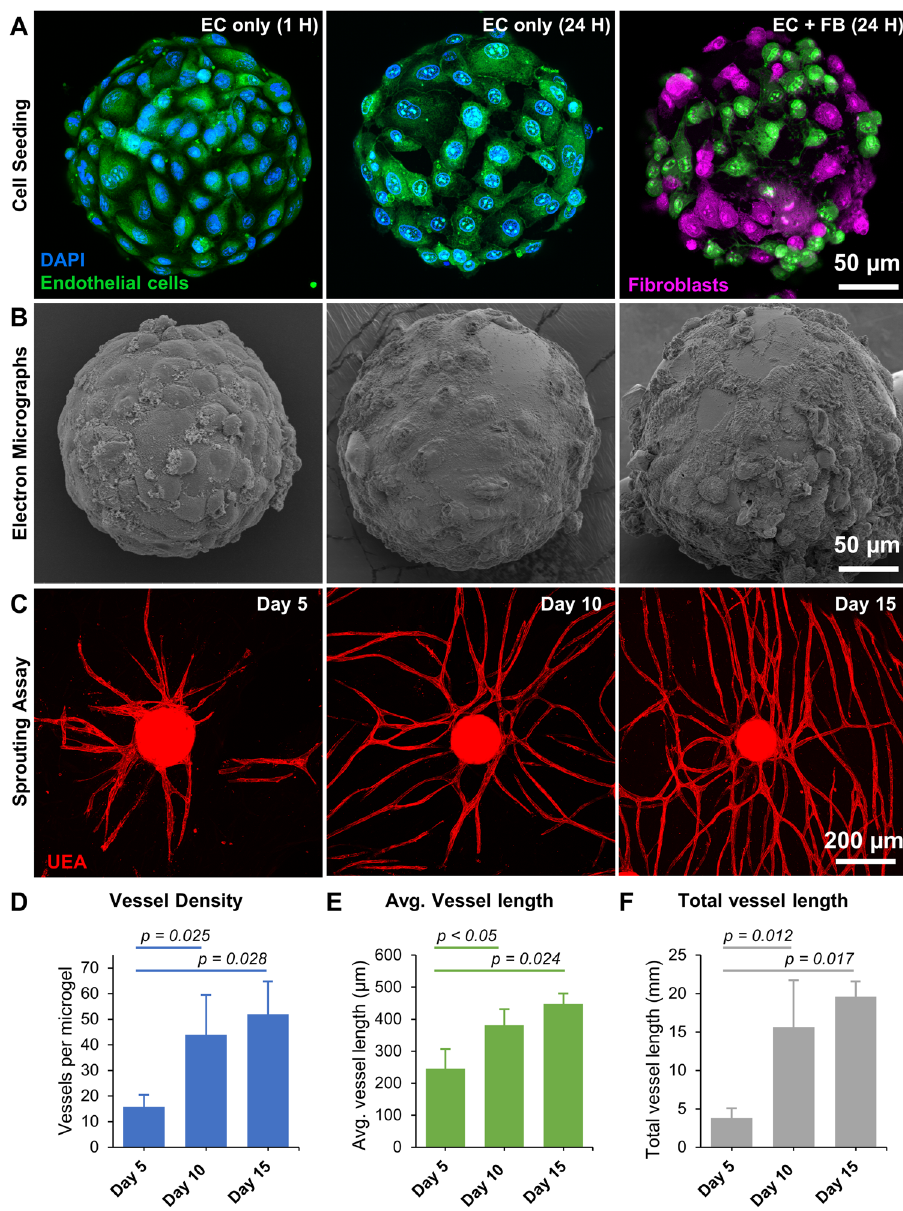
Figure 6. Gelatin microgels supported robust endothelial sprouting. ( A ) Confocal stacks of endothelial cells and fibroblasts seeded on gelatin microgels. The endothelial cells exhibit a typical ‘cobblestone’ monolayer pattern (left and center), which was changed when seeded with fibroblasts (right). ( B ) Corresponding scanning electron micrographs of microgels showing cell attachment to the microgel surface. ( C ) Endothelial sprouts radiating from the microgels formed vascular networks when embedded in a fibrin matrix. ( D ) Vessel density of microgel over time. ( E ) Average length of a vessel segment over time. ( F ) Total vessel length over time (n =